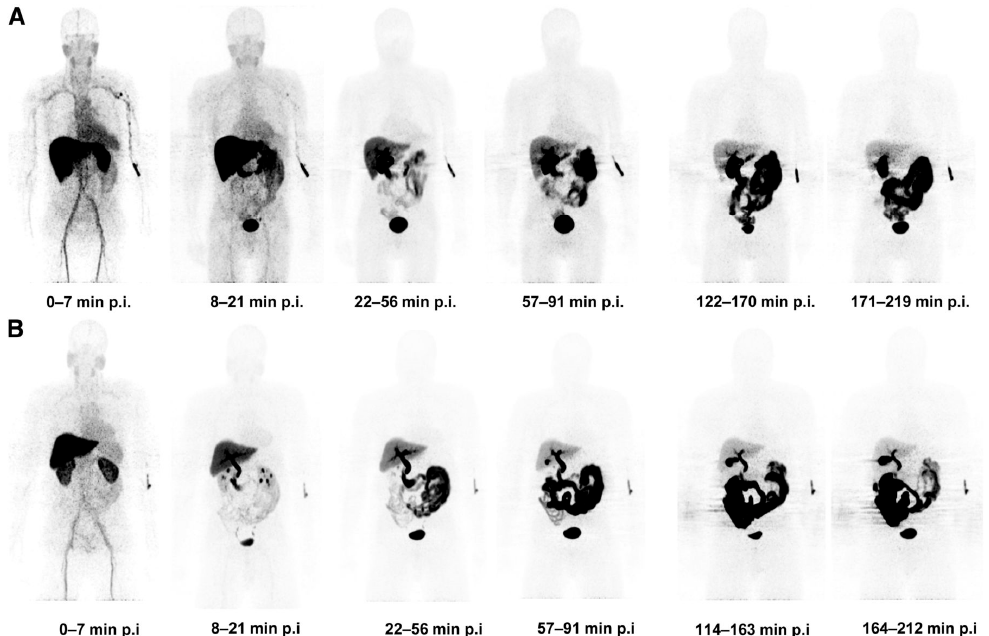
Figure 4. Biodistribution profile of series of [ 18 F]ICMT-11. The images correspond to whole-body maximum-intensity projection of representative subjects showing biodistribution of 18 F activity after tracer injection up to 219 min after injection of [ 18 F]ICMT-11. ( A ) A subject who had a meal 2–3 h before tracer injection; ( B ) a subject who had a meal just before tracer injection (due to delays in tracer production). Reprinted with permission from ref. [34]. Copyright 2013 SNMMI.